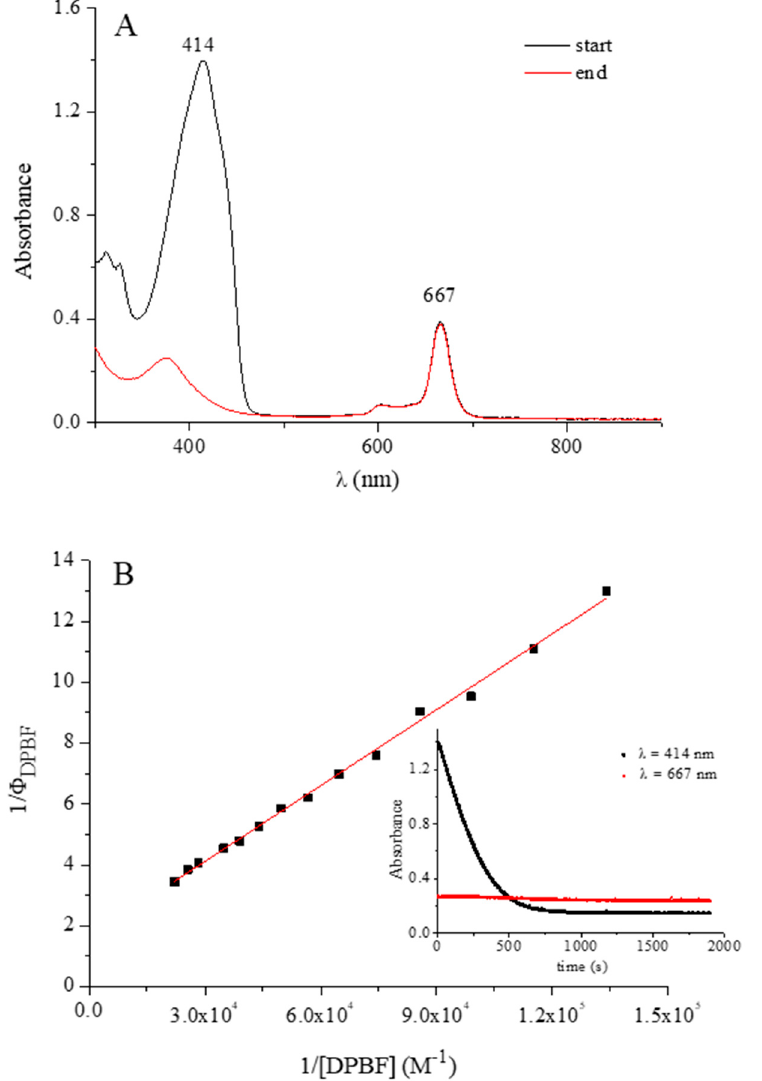
Figure 15. ( A ) UV-visible spectra in DMF solution of [Py 8 TPyzPzIn(OAc)] and DPBF before (black line) and after (red line) laser irradiation ( λ irr = 670 nm). ( B ) Stern-Volmer data analysis of the DPBF photooxidation (DPBF absorption decay at 414 nm is shown in the inset; the red dotted line indicates stability of the complex during irradiation).